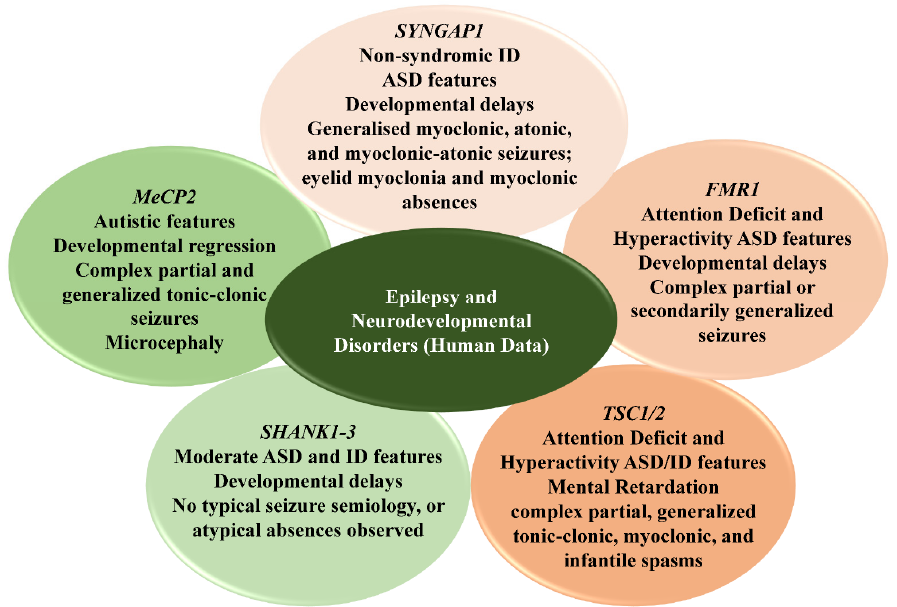
Figure 1. Common pathophysiological features of epilepsy in genes implicated in human NDDs. Diagram illustrating neurodevelopmental phenotypes, predominant seizure types, and electroen- cephalographic hallmark characteristic features observed in patient cohorts of neurodevelopmental disorders. ASD/ID, autism spectrum disorder/intellectual disability; FMR1, fragile X mental retar- dation protein 1; TSC1/2, tuberous sclerosis complex 1/2; SHANK1-3, SH3 and multiple ankyrin repeat domains 1-3; MeCP2, methyl CpG binding protein 2; SYNGAP1, synaptic Ras-GTPase acti- vating protein rat homolog 1.